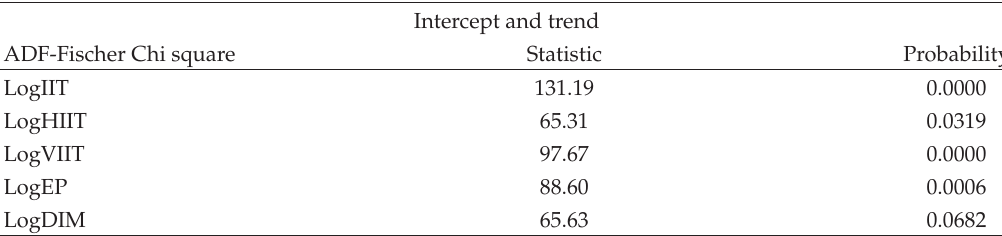
Table 2: Panel unit root test